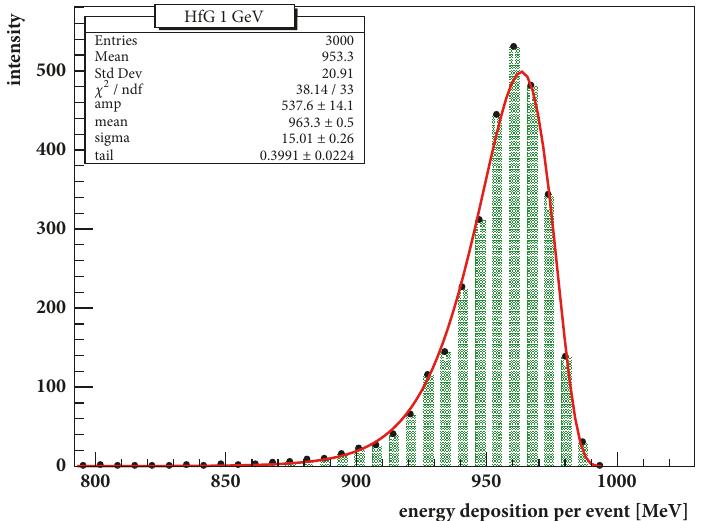
Figure 1: Typical energy resolution fitting belonging to HfG scintillator for 1 GeV beam